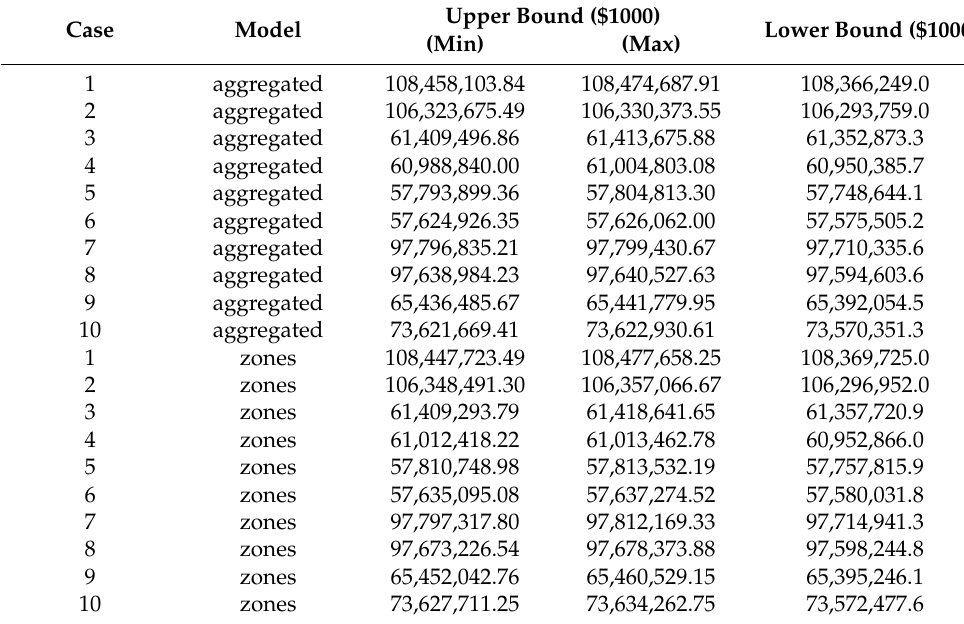
Table 3. Ranges of the upper and lower bounds over the 5 trials of each